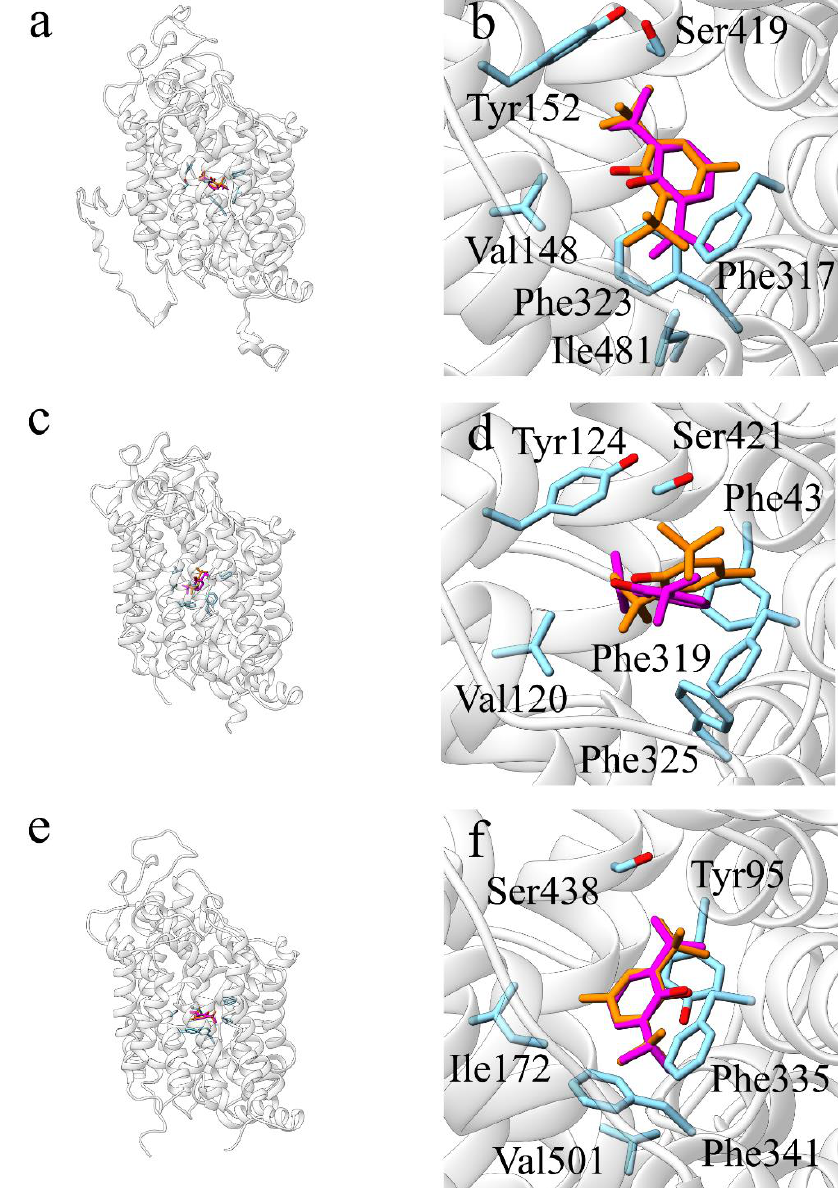
Figure 4. Depiction of the best poses for BHT and PFL binding to hNET, dDAT and hSERT obtained by docking simulations. The best docking poses for BHT (orange) and PFL (magenta) are illustrated in ( a , b ) for hNET, in ( c , d ) for dDAT, and in ( e , f ) for hSERT, respectively. Interacting residues are shown as stick (coloured by atom type, carbon atoms in cyan).